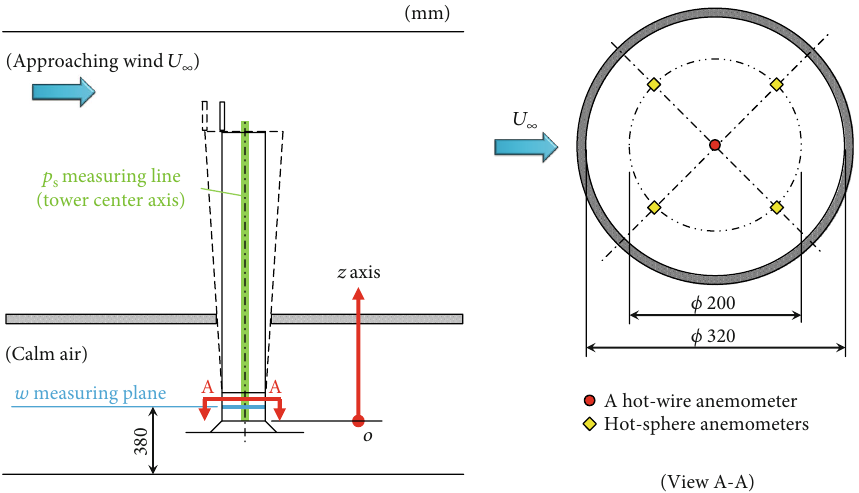
Figure 3: The measuring points of the updraft speed w and static pressure di ff erence Δ p